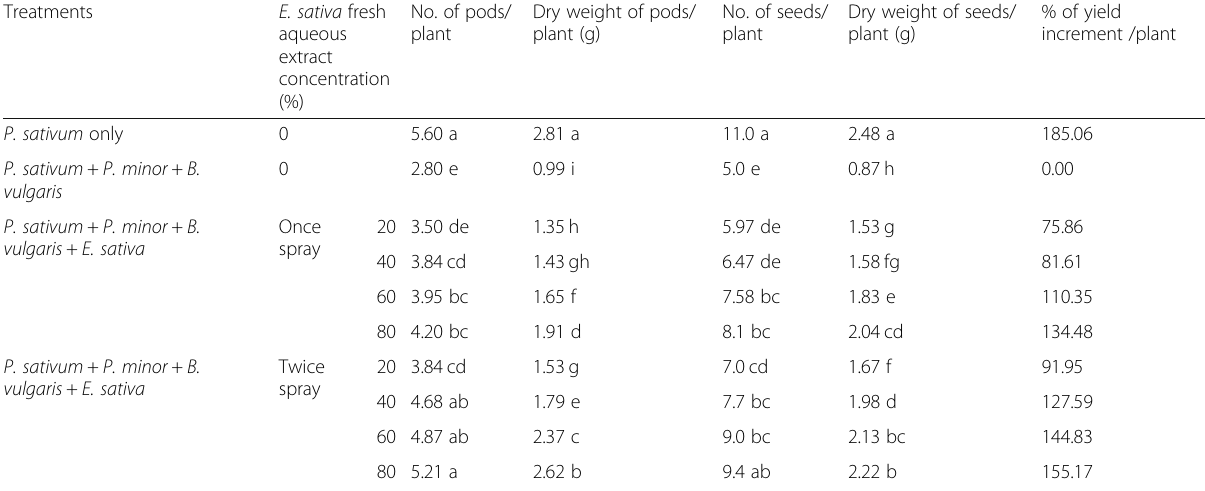
Table 4 Effect of spraying different concentrations of E. sativa fresh aqueous extract on yield and it ’ s attributes of P. sativum plants. (Combined analysis of the two seasons)